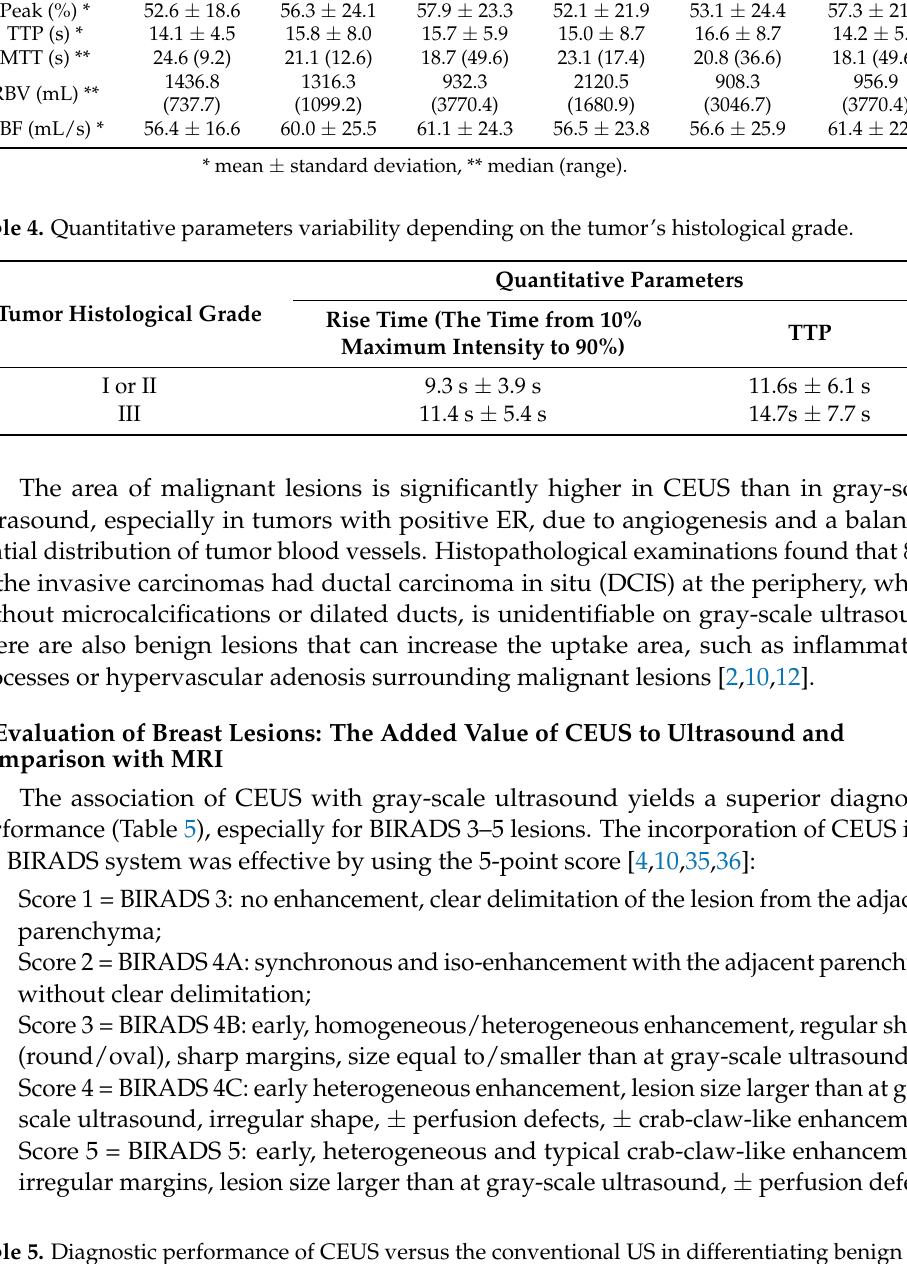
Table 5. Diagnostic performance of CEUS versus the conventional US in differentiating benign and malignant breast lesions—results from a meta-analysis including different studies in the two groups [35]. CEUS Versus the US CEUS + US Versus US Pooled Values CEUS US CEUS + US US